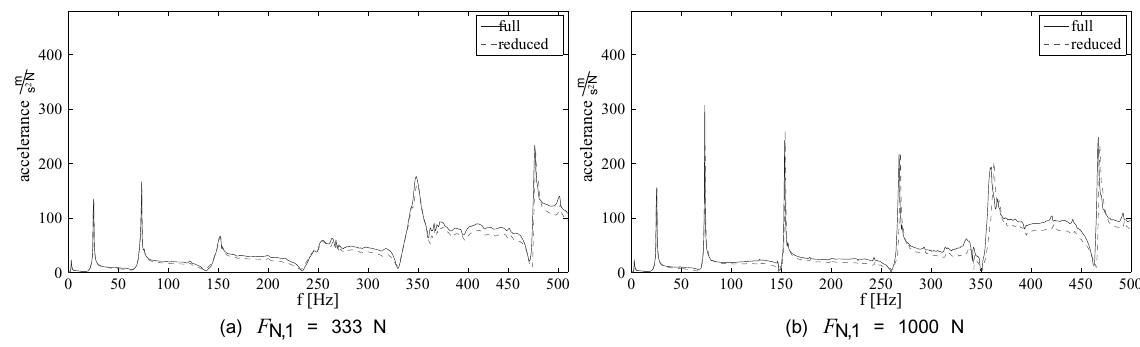
Fig. 7. FRFs for impulse excitation with method B for different normal forces (note the linear